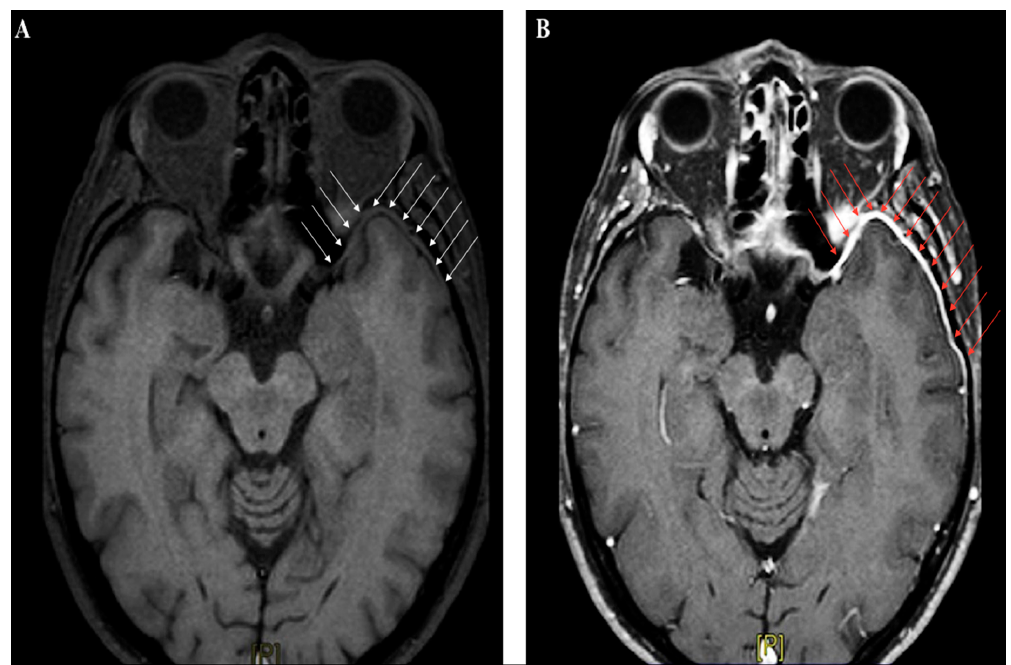
Figure 3. Brain magnetic resonance imaging (MRI) (axial section, T1-weighted images) performed in a patient with recurrent headache and diplopia, and a history of remote head trauma; a definite thickening of the meningeal lining over the left anterior temporal lobe (white arrow panel A ), with following contrast enhancement (red arrow panel B ), can be clearly